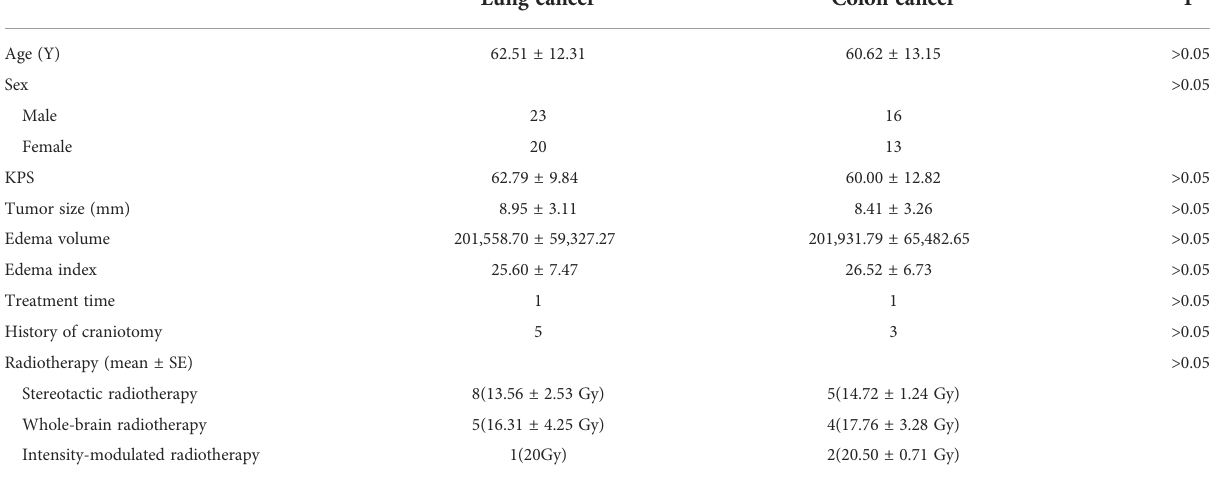
TABLE 1 Demographic characteristics of two